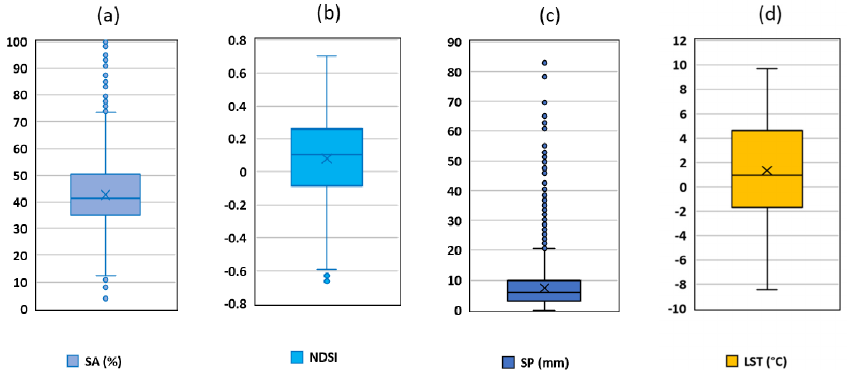
Figure 2. Daily mean of snow albedo ( a ), NDSI ( b ), snow precipitation ( c ), and temperature ( d ) for the studied area in the SNSM from March 2000 to February 2020. Bars indicate first and second quartiles, while the points are extreme values outside of the interquartile range. (For interpretation of the references to color in this figure legend, the reader is referred to the web version of this